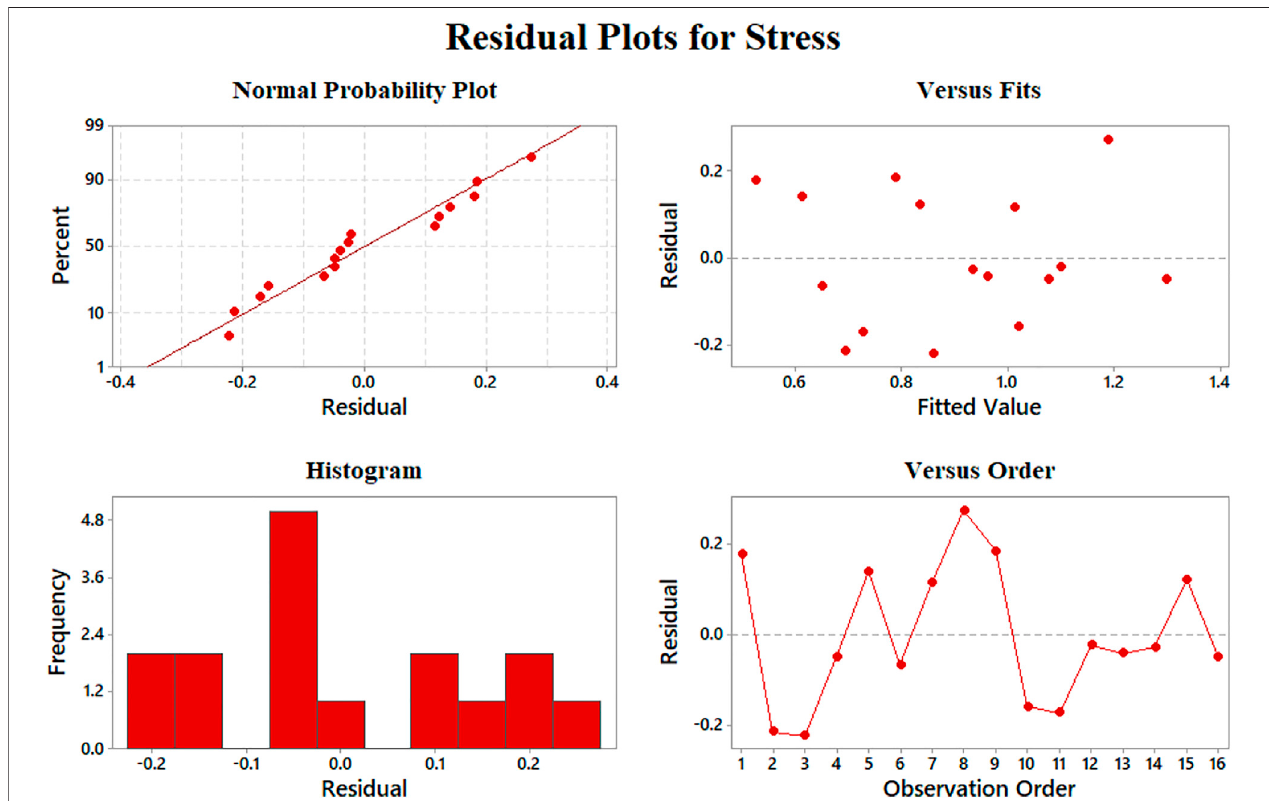
FIGURE 10 | Representing errors of the yield stress model: (A) normal probability, (B) versus fi t, (C) histogram, and (D) versus order.